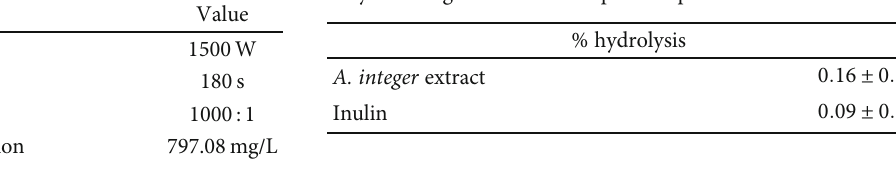
Figure 3: Response surface plot showing the e ff ect of microwave power and solvent-sample ratio on the total carbohydrate Table 7: Veri fi cation of model. Table 9: Percentage hydrolysis of A. integer and inulin after enzymatic digestion and absorption at pH 7.